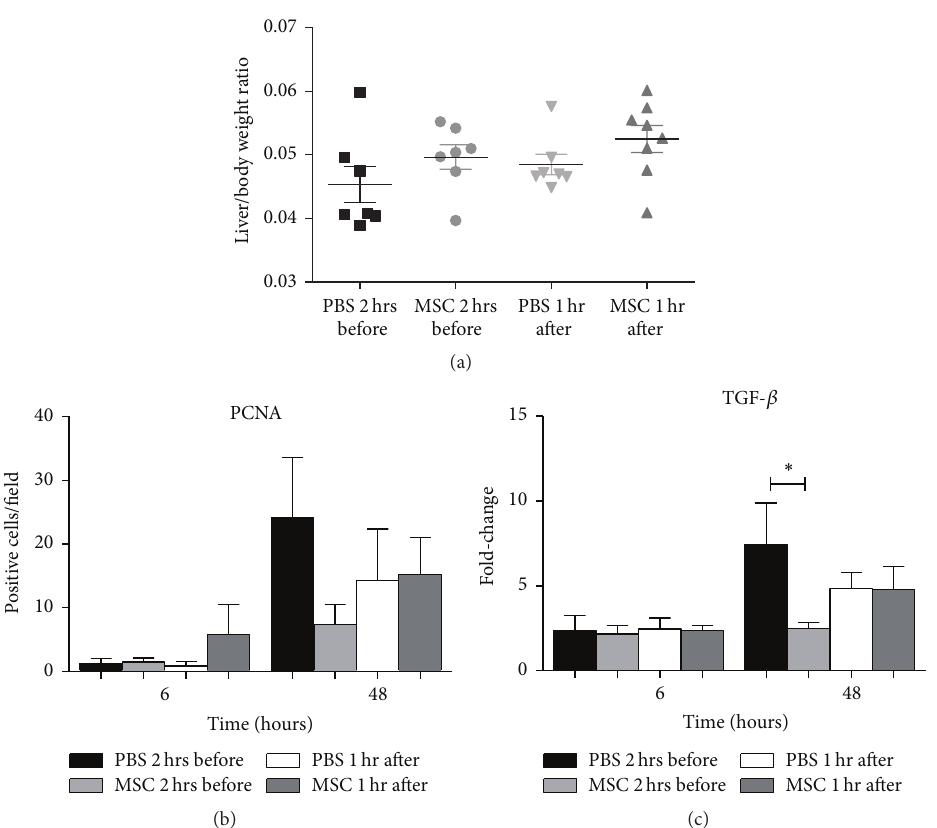
Figure 3: Liver regeneration. (a) Liver/body weight ratio 5 days after IRI and PH showed no significant differences between MSC or PBS treated mice. (b) After 6 and 48 hours after IRI and PH the numbers of PCNA positive cells were not significantly different. (c) Regeneration marker TGF- 𝛽 showed significantly higher expression levels forty-eight hours after reperfusion in mice treated with PBS 2 hours before IRI and PH. The data are expressed as means ± SEM (( ∗ 𝑃 < 0.05 ) versus their PBS controls).